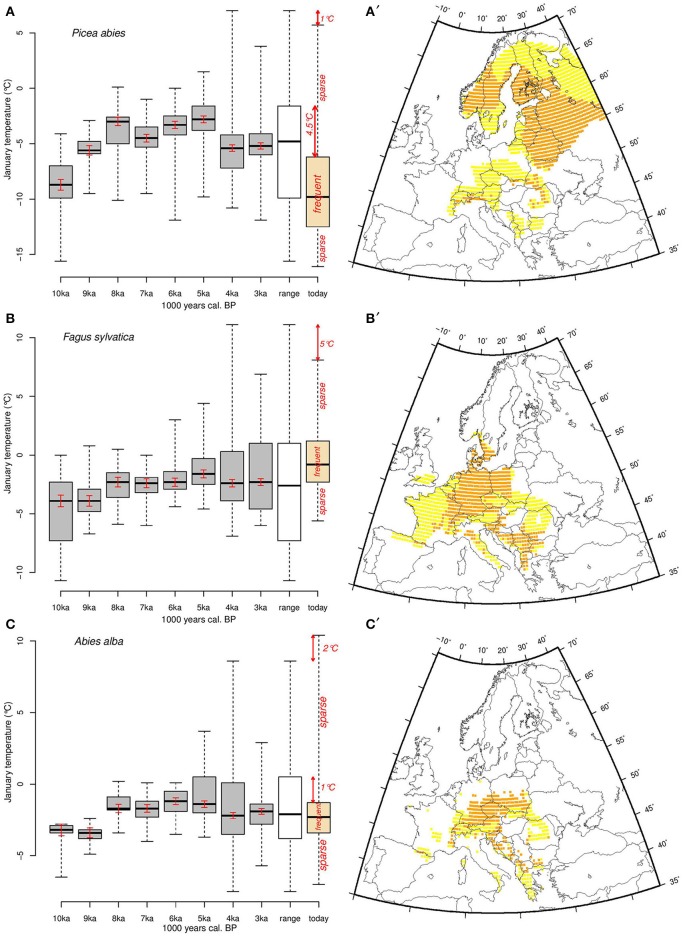
Thermal amplitude of (A) Picea abies, (B) Fagus sylvatica, and (C) Abies alba for each 1000-year time slice between 10,000 and 3000 years cal. BP (gray boxplots), the Holocene overall (white boxplots), and the modern (orange boxplots) ranges, respectively. The black line is the median, the boxes represent the first and third quartiles (25 and 75th quartiles, respectively), and the whiskers represent the minimum and the maximum Tjan range. We consider the boxes and the whiskers as the Tjan ranges where populations are frequent and sparse, respectively. Red arrows indicate differences between current limits of Tjan distribution and those over the Holocene. Maps show today's areas of Picea abies
(A′), Fagus sylvatica
(B′), and Abies alba
(C′) where Tjan values correspond to the range between the first and third quartiles (orange, corresponding to areas where the species are most abundant) and more extreme values (yellow). The red bars inside the boxes correspond to the estimated uncertainty related to random spatial sampling and to sample size in Monte Carlo simulations.